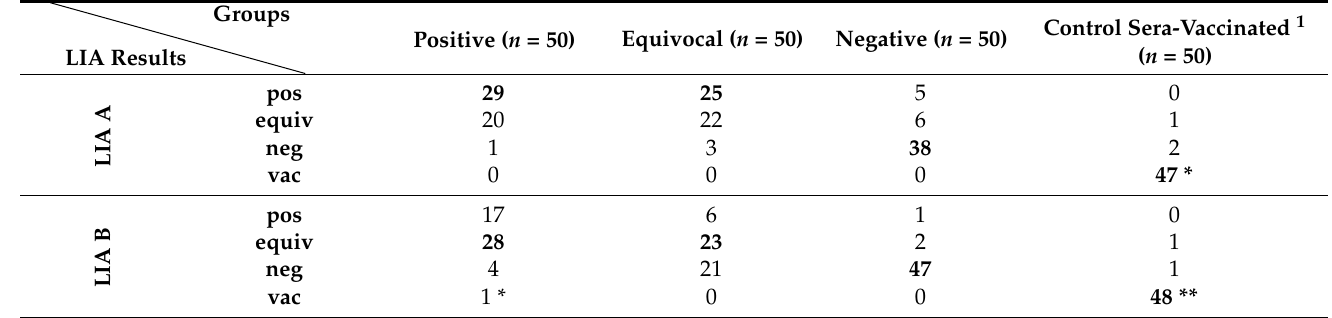
Table 10. Defined serostatus of horses (groups; n = 200) and allocated results using LIA A and LIA B. (Specific samples were tested two time as described